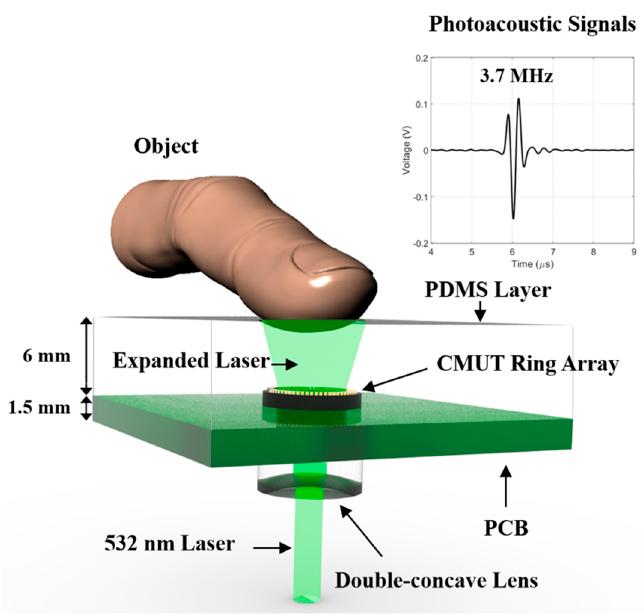
Figure 2. Overall configuration of the photoacoustic (PA) system with a-scan data detected acoustic